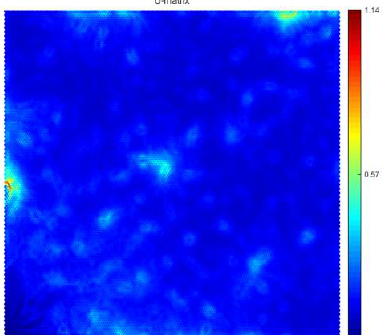
Figure 6. U-matrix presentation in SOM for one Sentinel 2 tile of the study area.